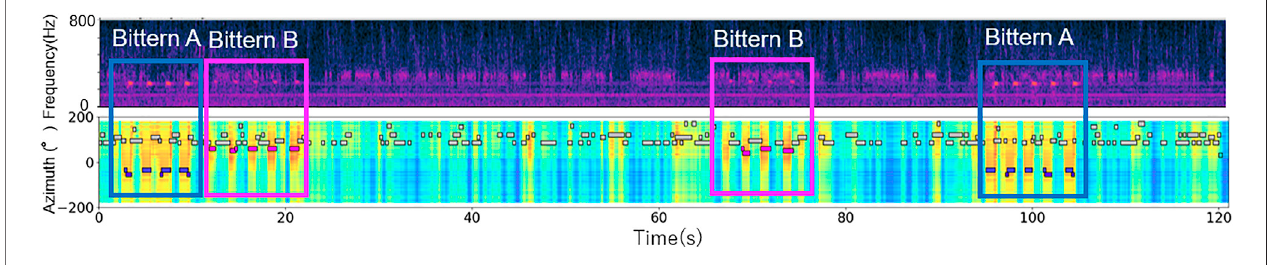
FIGURE 9 | Examples of localized sound including the two bitterns ’ calls.